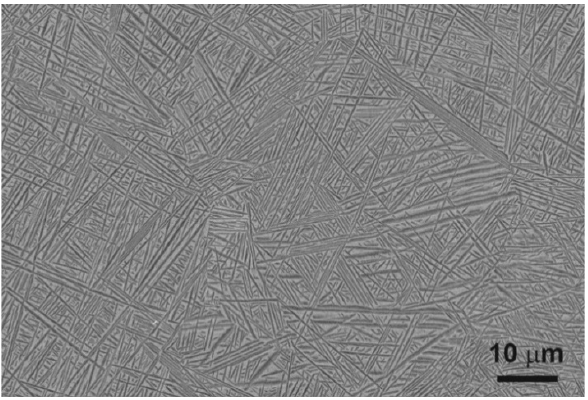
Figure 1. Microstructure of the as-received alloy.